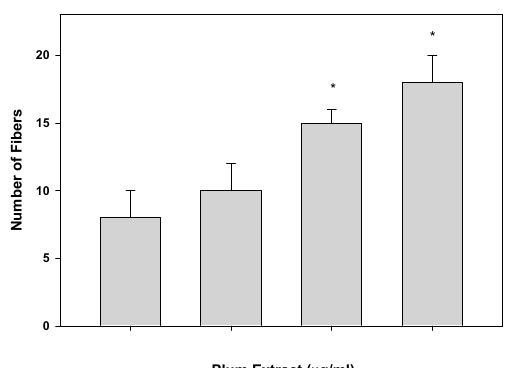
Figure 2. The effect of plum extract on C2C12 myoblast differentiation. ( a ) Images of differentiated cells after treatment with varying concentration of plum extract showing nuclei stained in blue (Hoechst 33342) and myofibers stained in green (Alexa 488). Pictures were taken at 200× magnification using a Nikon Fluorescent Microscope. The bar represents a length of 300 µm. ( b ) Fused cells from five random fields were counted manually under 200× as described in “Materials and Methods”. The data are expressed as mean ± SD for at least three experiments. All comparisons were made to control (untreated cells) using one-way ANOVA; significant differences are reported at * p < 0.05.